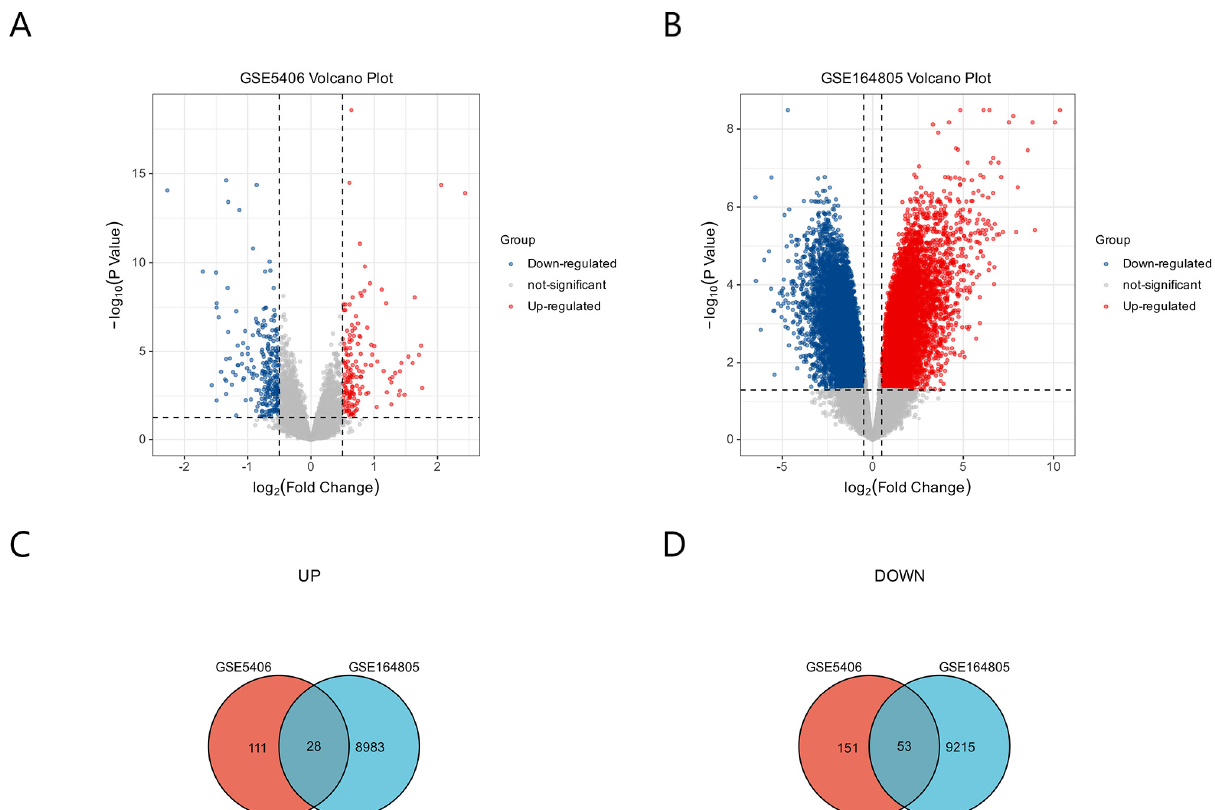
Figure 2. Identification of DEGs common to COVID-19 and ICM using GEO2R. ( A ) DEGs from GSE5406 related to ICM. ( B ) DEGs from GSE164805 related to COVID-19. The p values are Bonferroni corrected/adjusted p values. ( C ) DEGs co-up-regulated by COVID-19 and ICM. ( D ) DEGs co-down-regulated by COVID-19 and ICM.